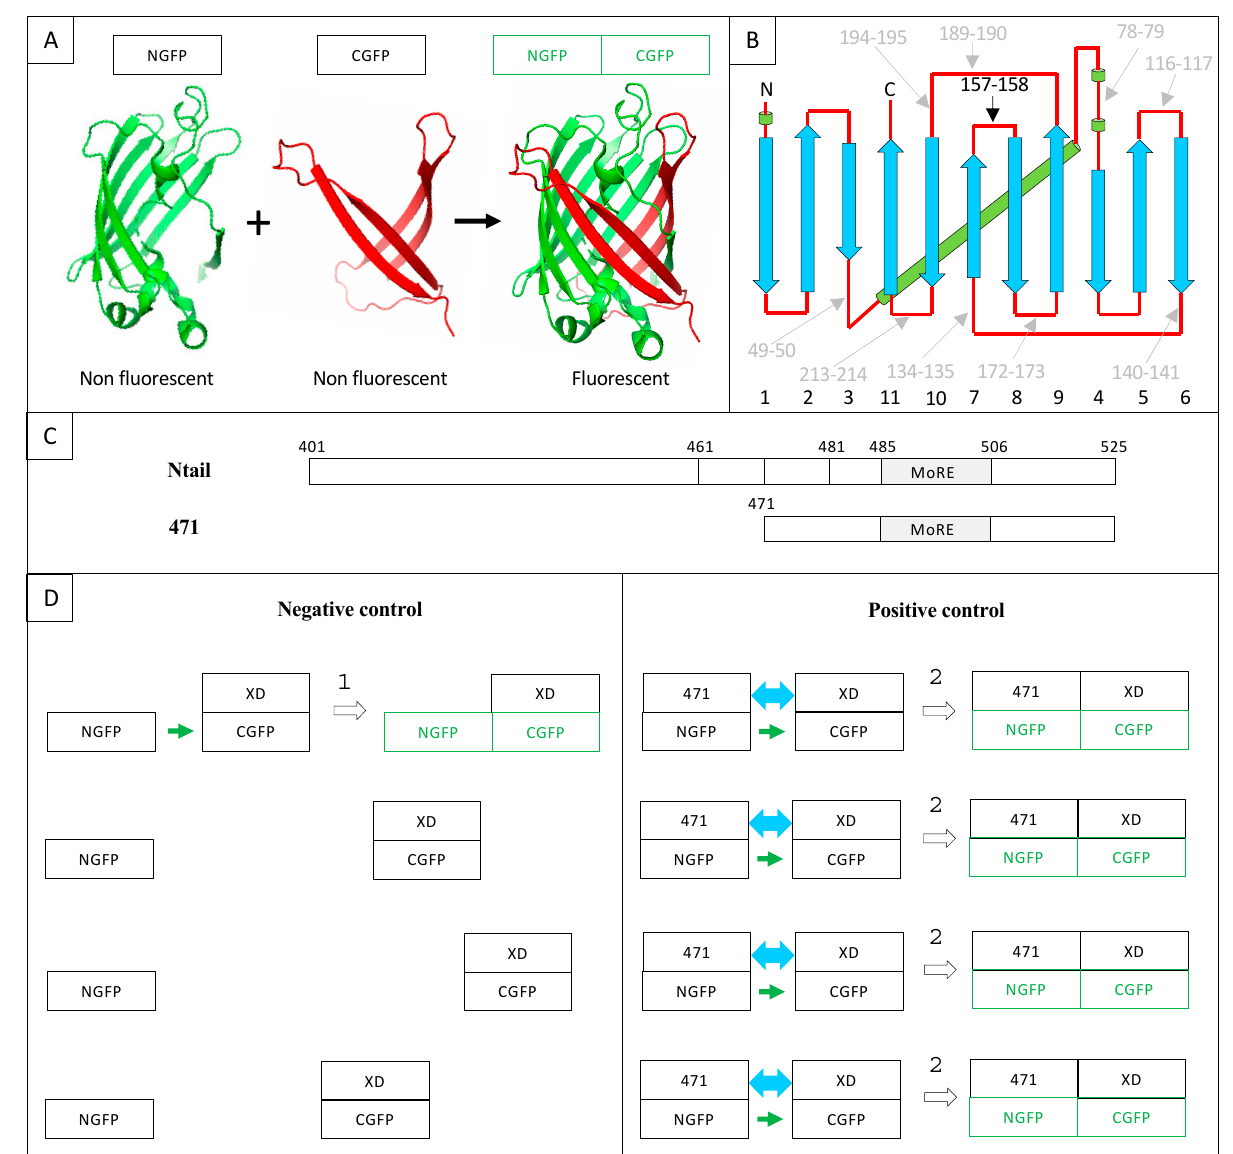
Figure 1. ( A ) Split-GFP reassociation. Cartoon representation illustrating how NGFP (1–157) and CGFP (158–238) reassociate to recreate the fluorescent protein. ( B ) GFP topology diagram. β -strands are represented as blue arrows and numbered below the drawing, α -helices are represented as green cylinders and loops as red lines. The internal α -helix containing the chromophore is represented behind the structure. N, N-terminus. C, C-terminus. The different splitting points tested by Abedi et al. [19] are located on the GFP structure. Cutting sites resulting in low GFP fluorescence are in grey, while the cutting point eventually retained by Ghosh et al. [13] (i.e., 157–158) is shown in black.